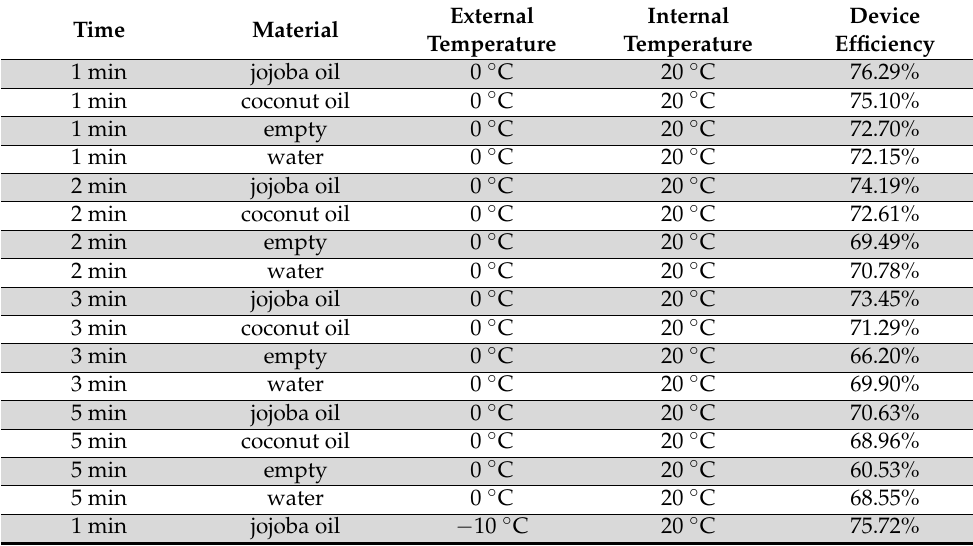
Table 5. Unit efficiency with heat exchanger